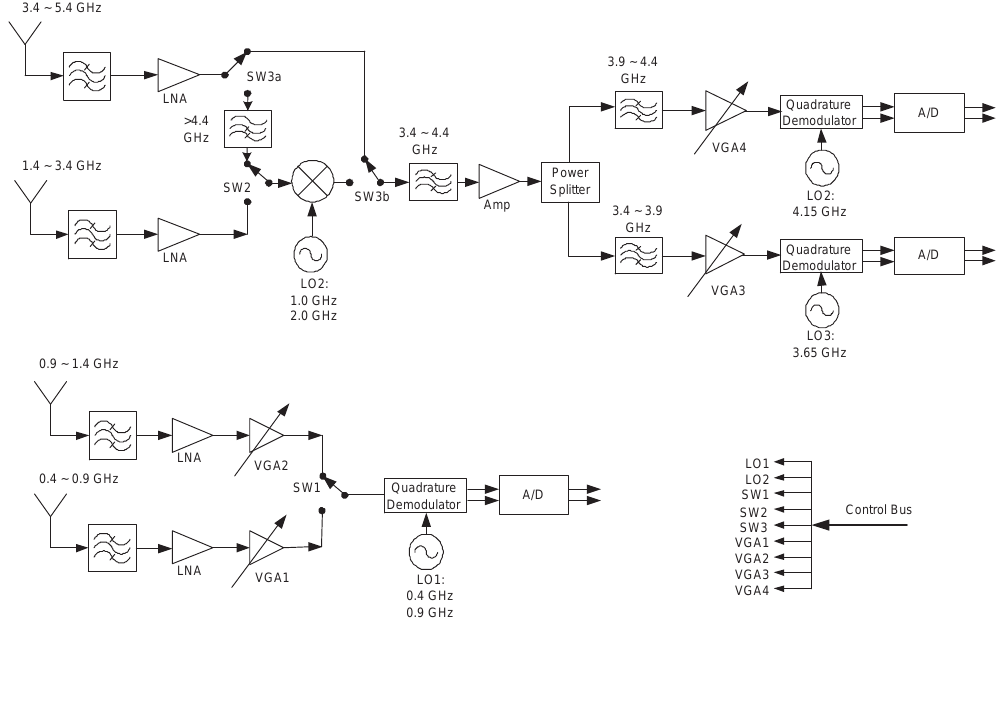
Table 3. Receiver frequency parameters